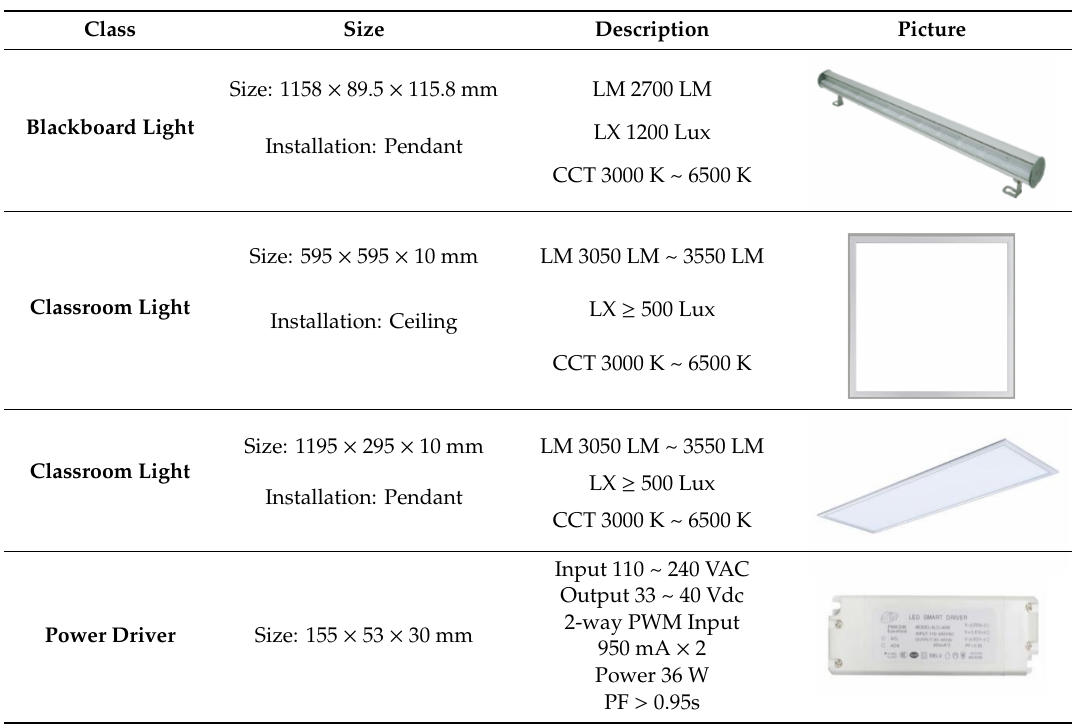
Table 7. LED lighting fixtures and power driver.